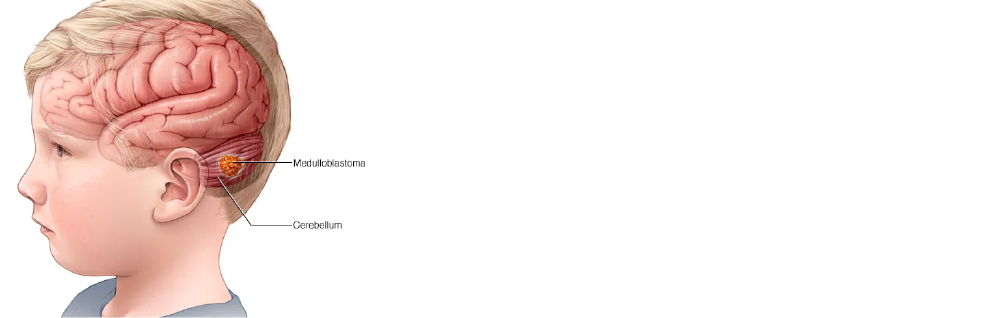
Figure 7. Medulloblastomas: brain tumour of type 3 (source: https://www.mayoclinic.org/diseases-